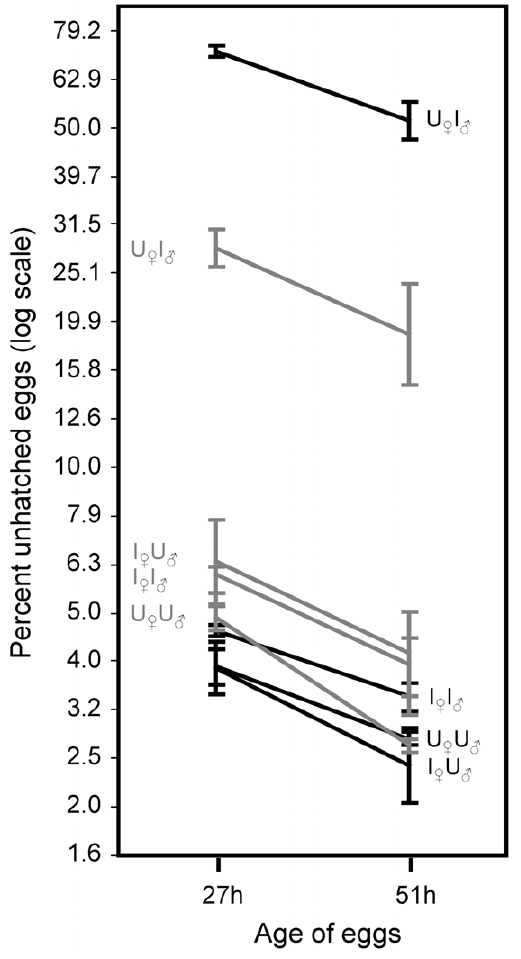
Figure 1. Cytoplasmic incompatibility: male age and embry- onic development time. Proportion of unhatched eggs produced from all four combinations of infected and cured males and females. Males of two ages were used (black lines 1-day-old males, grey lines 3- day-old males) and eggs hatch was scored at two different times (first after 27 h and then again after 51 h). For each line there is a letter combination. The first letter correspond to the infection status (U=uninfected, I=infected) of the female (subscripted with R ), the second letter refers to the infection status of the male (subscripted with = ). Note that the Y-axis is log transformed.